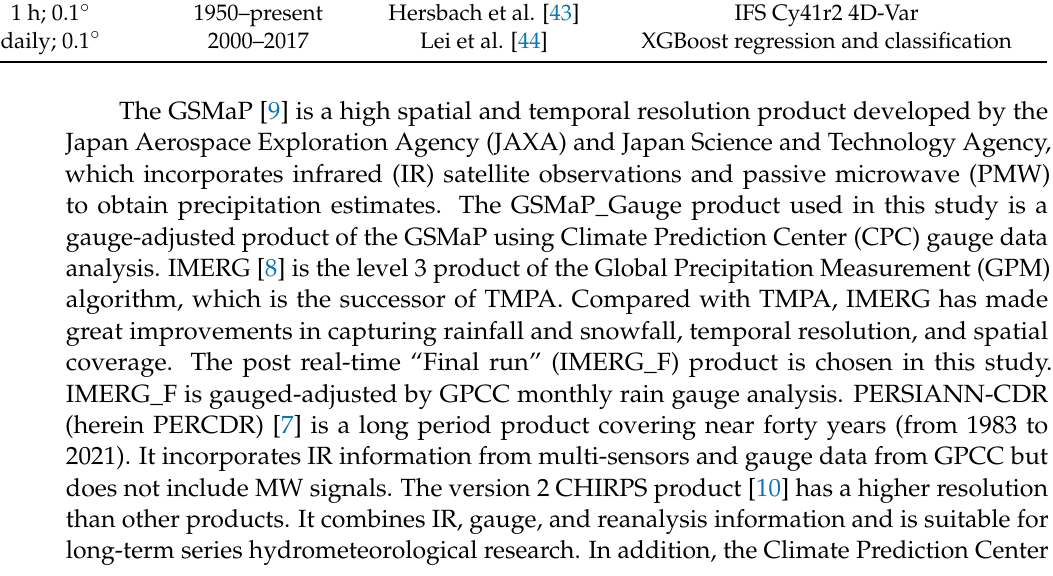
Table 1. The information of precipitation products used in this study.